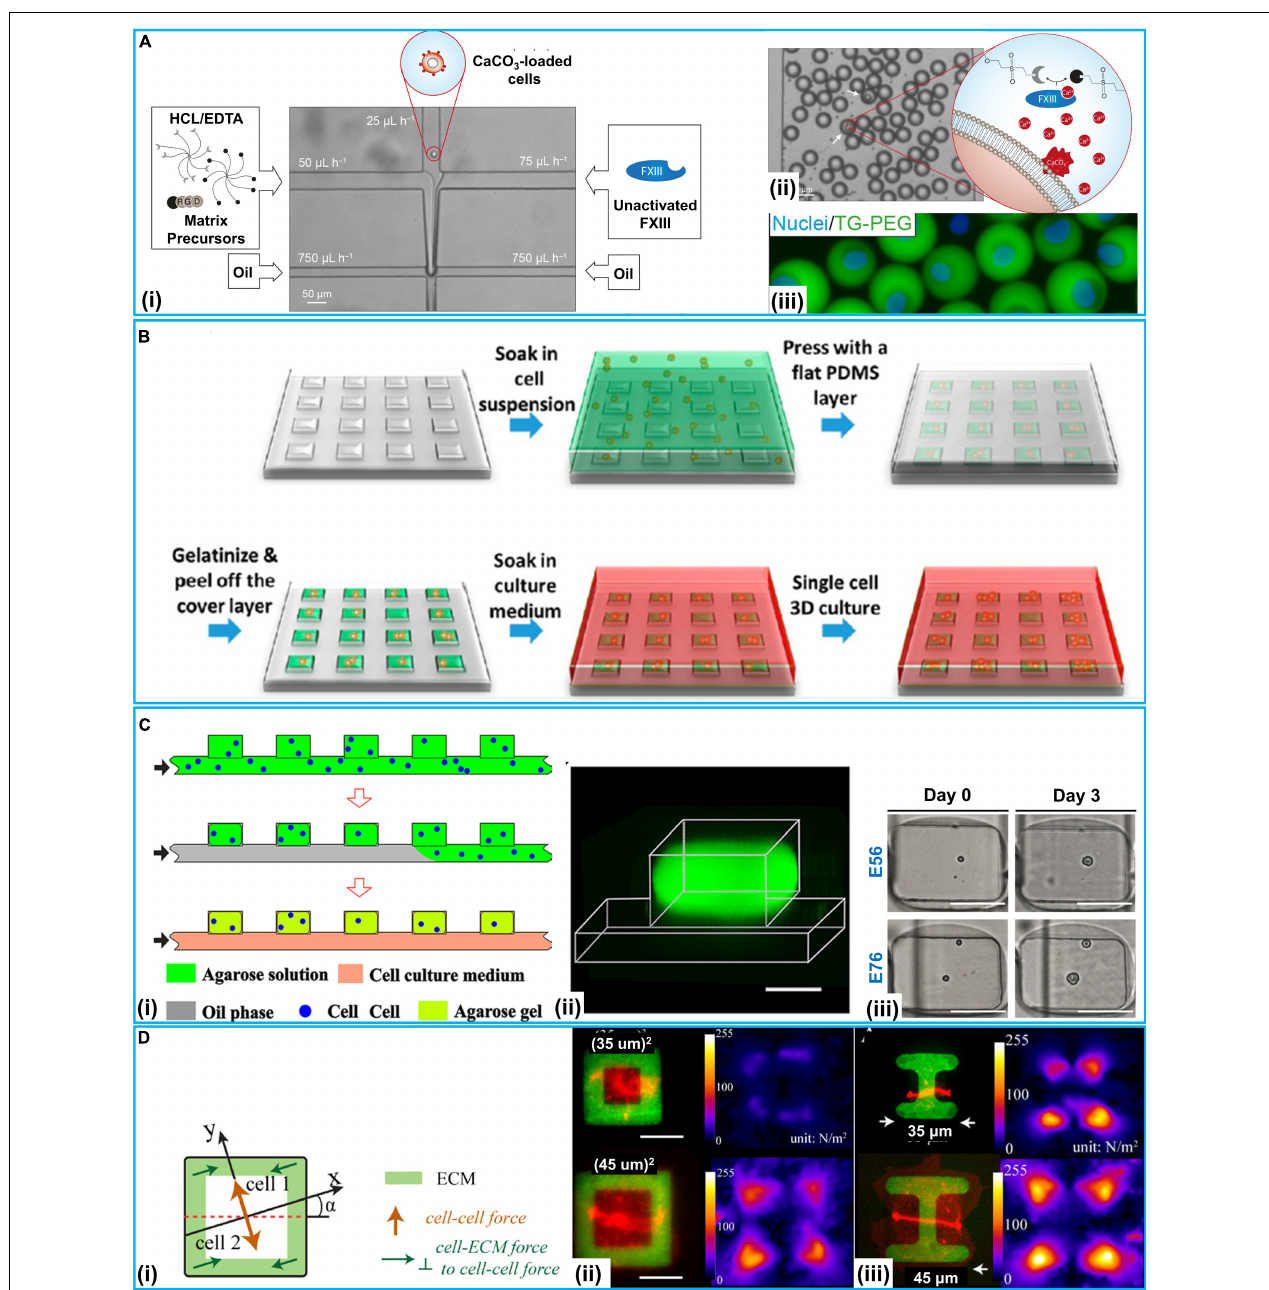
FIGURE 4 | 3D microfluidic intercellular interaction systems at the single-cell level. (A) TG-PEG-hydrogel microniches for cell–ECM communication. (i) Microfluidic chip for cell-laden TG-PEG droplet generation. (ii) Resultant TG-PEG droplets. If a cell was present in the droplet (white arrows), CaCO3 would be dissolved and Ca2+-induced activation of FXIII occurred for microniche formation. (iii) Fluorescence image of MSCs stained with Hoechst 33342 (Nuclei) encapsulated in FITC labeled TG-PEG hydrogel after retrieval from the emulsion and transfer to cell culture. Reproduced with permission from Lienemann et al. (2017), copyright 2017 The Royal Society of Chemistry. (B) Schematic of µ CGA (micro-collagen gel array) fabrication process for 3D cell culture. Reproduced with permission from Guan et al. (2014), copyright 2014 American Chemical Society. (C) Microfluidic generation of hydrogel modules (HMs) for cell–cell interaction study. (i) Schematic of the generation of cell laden agarose HMs. (ii) 3D confocal fluorescence microscopy image of an individual HM formed in the well from FITC-conjugated agarose. (iii) Optical images (top view) of the cells compartmentalized in HMs for 3-day culture, scale bars: 100 µ m. Reproduced with permission from Wang et al. (2016), copyright 2016 AIP Publishing. (D) Cell–cell and cell–ECM forces study with patterned ECM. (i) Schematic illustration of cell–cell and cell–ECM forces in cell pairs. (ii) Pairs of E-cadherin–DsRed MDCK cells spread fully on ECM squares containing collagen I and Alexa Fluor 488-labeled gelatin (green), showing a larger total force generated by the cell pair on the larger square. (iii) Pairs of E-cadherin–DsRed MDCK cells on I-shaped ECM. Reproduced with permission from Sim et al. (2015), copyright 2015 The American Society for Cell Biology.